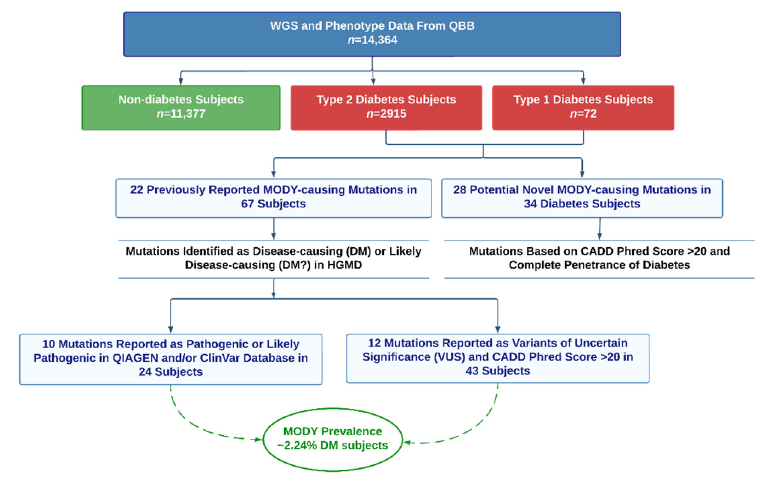
Figure 1. Study Design. This study was based on whole-genome sequencing (WGS) data of the Qatar Biobank (QBB) participants. The analysis cohort comprised n = 14,364 subjects, classified into diabetes mellitus subtypes (T1DM; n = 72 and T2DM; n = 2915) and non ‐ diabetes subjects ( n = 11,377) based on phenotypic data. The detected mutations were classified into previously known or potentially novel MODY ‐ causing mutations based on pathogenicity annotations in the human gene mutation database (HGMD), QIAGEN Clinical Insight and ClinVar databases or Combined Annotation-Dependent Depletion (CADD) scores, as well as on disease (diabetes mellitus) penetrance. Table 1. Clinical characteristics of study cohort.